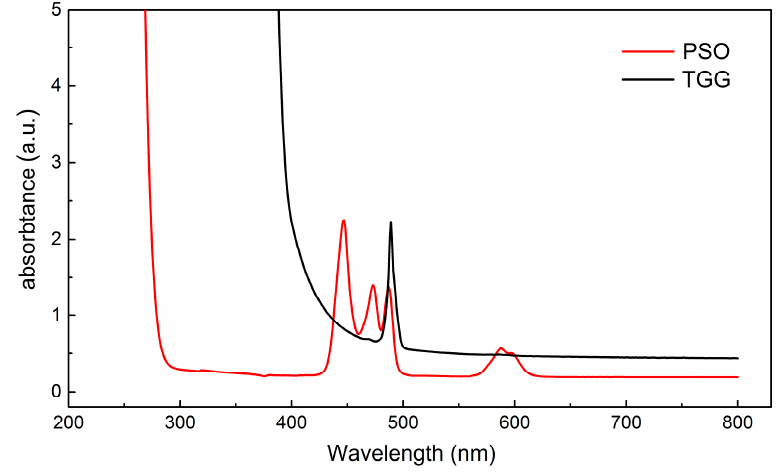
Figure 3. Absorption spectra of as-grown PSO crystal in comparison with that of commercial TGG crystal.